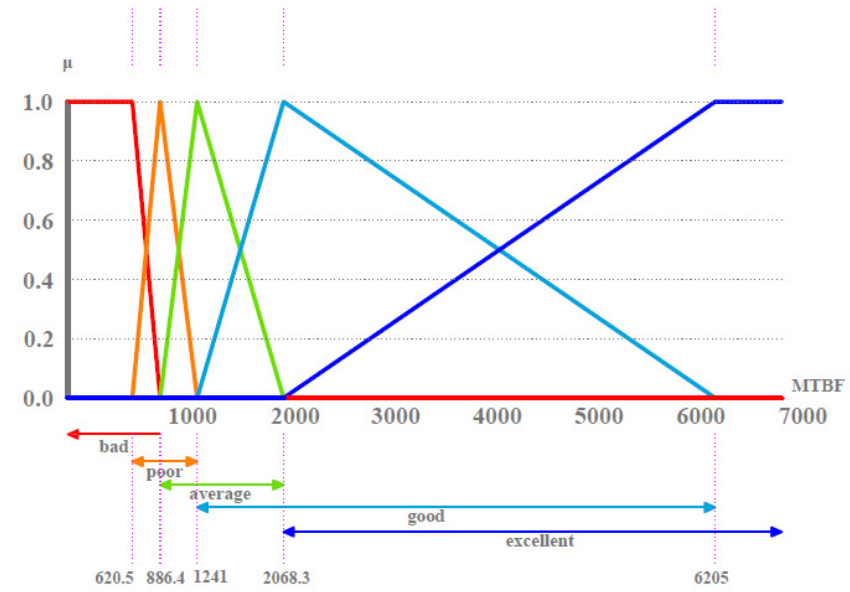
Figure 7. Membership functions of the condition scale for